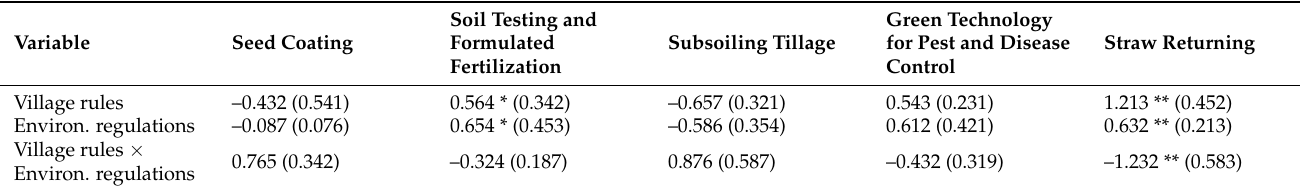
Table 3. Interaction between village rules and formal environmental